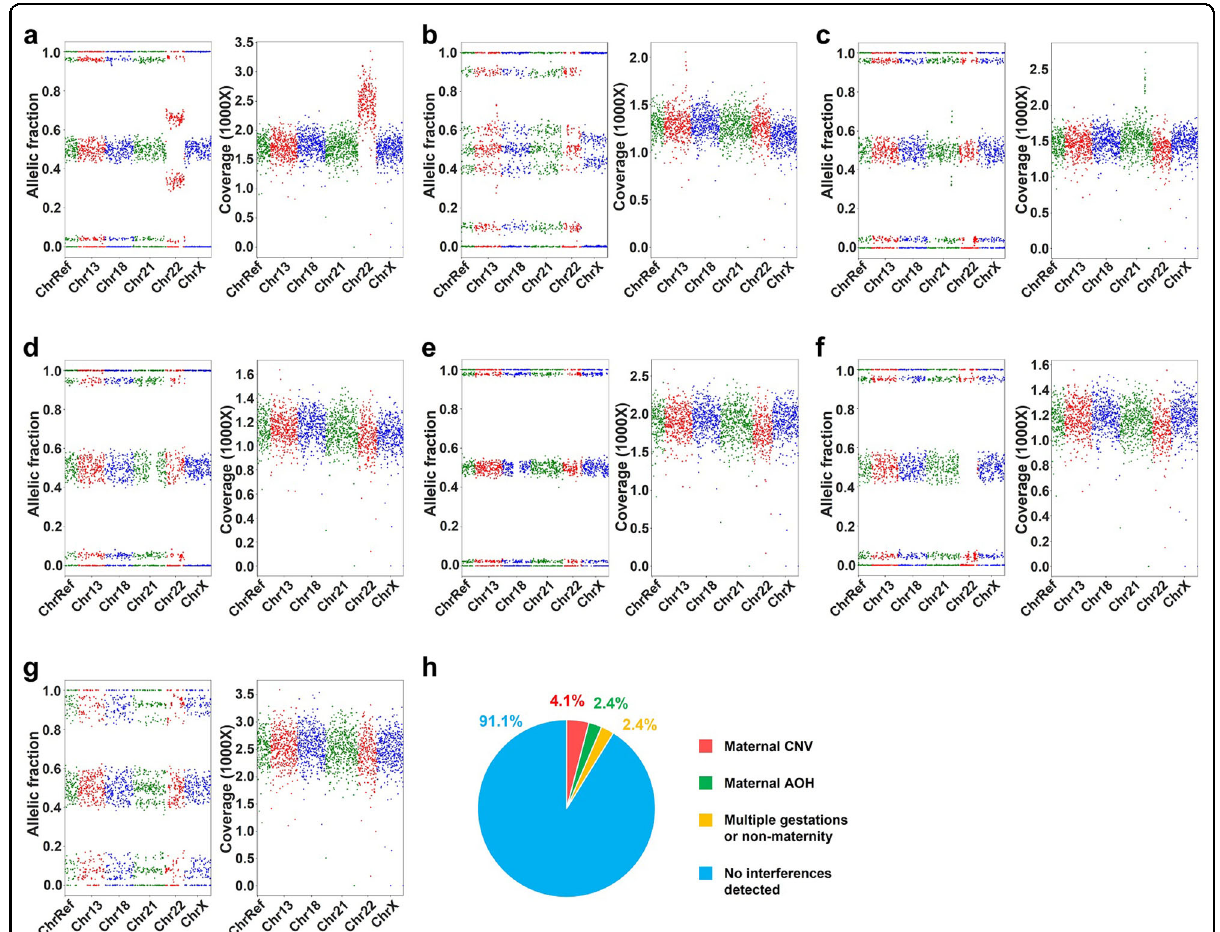
Fig. 3 Genetic deconvolution of fetal and maternal cfDNA admixtures precludes maternal interference. a – c Representative cases with maternal CNV revealed by changes in both the SNP AF and RD panels, including a ~3.1 Mb duplication ( a ), a ~0.35Mb duplication ( b ), and a ~0.5 Mb duplication ( c ). d – f Representative cases with maternal AOH revealed by changes in the SNP AF panel only, including a ~3.2 Mb AOH region on chr21 ( d ), a ~16 Mb AOH region on chr18 ( e ), and a ~3.1 Mb AOH region on chr22 ( f ). g A representative case of a dizygotic twin pregnancy with both an increased number of detected fetal SNPs and their AF variation. h Percentages of cases with multiple gestations or non-maternity, and cases with maternal CNV (size > 200 kb) or maternal AOH regions ( ≥ 75 consecutive homozygous SNPs) detected on chr13, chr18, chr21, chr22, and chrX.